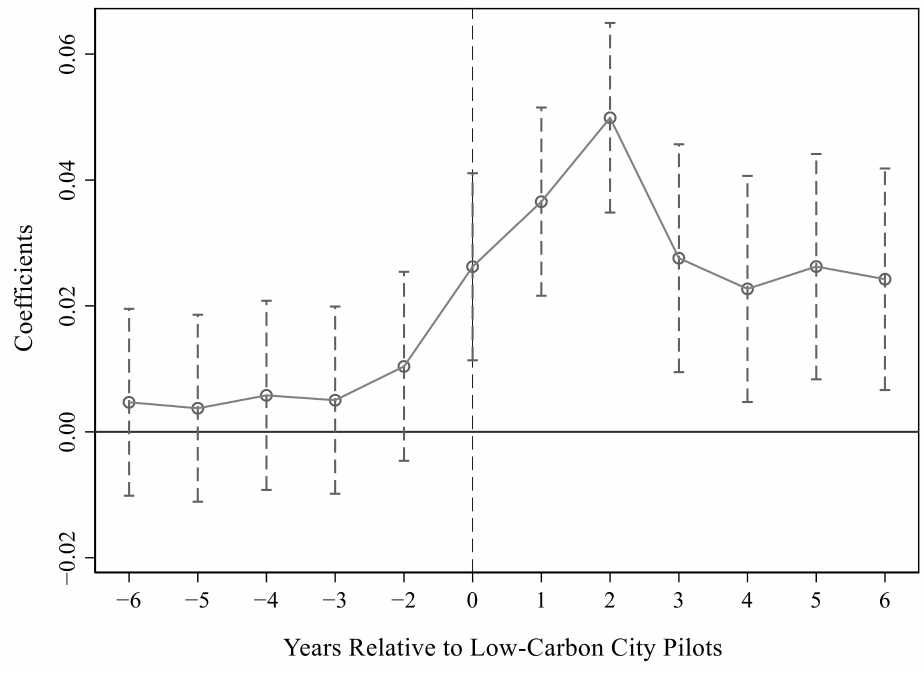
Figure 3. Parallel trend test in the third column of Table